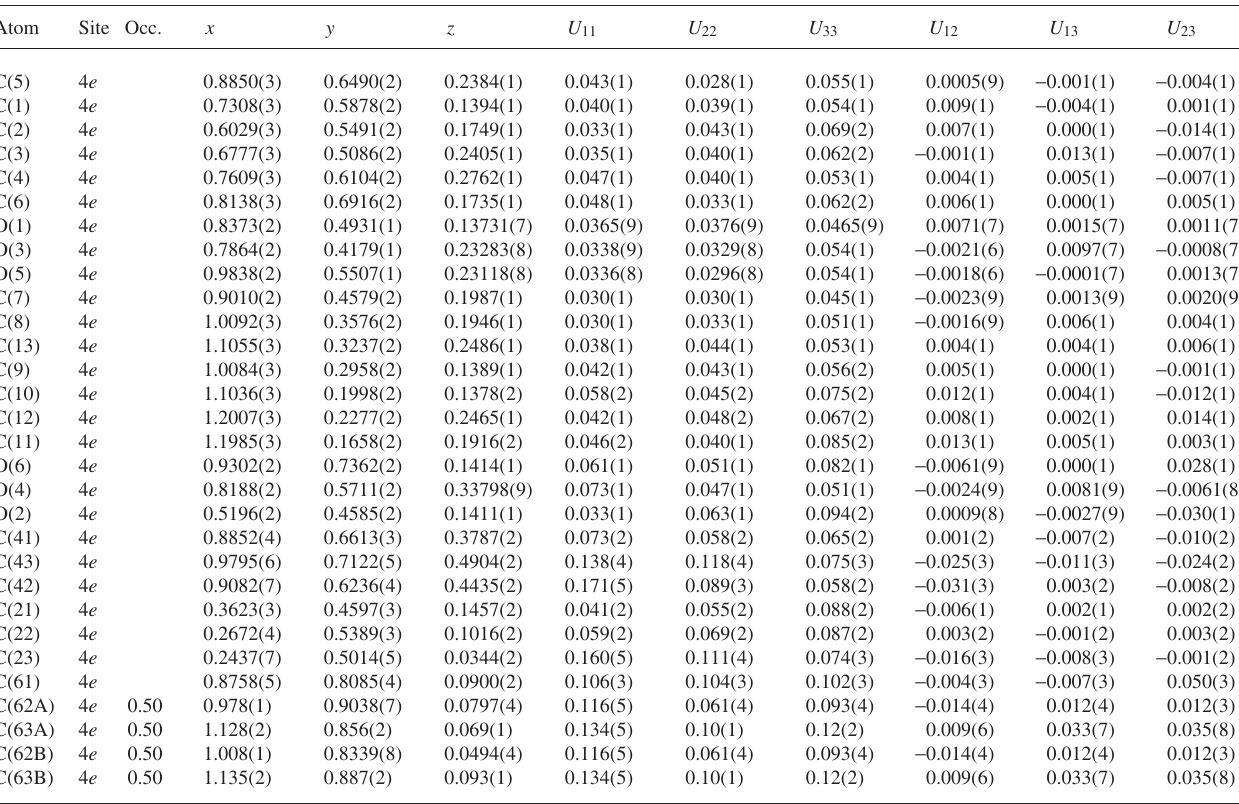
Table 3. Atomic coordinates and displacement parameters (in Å 2 )